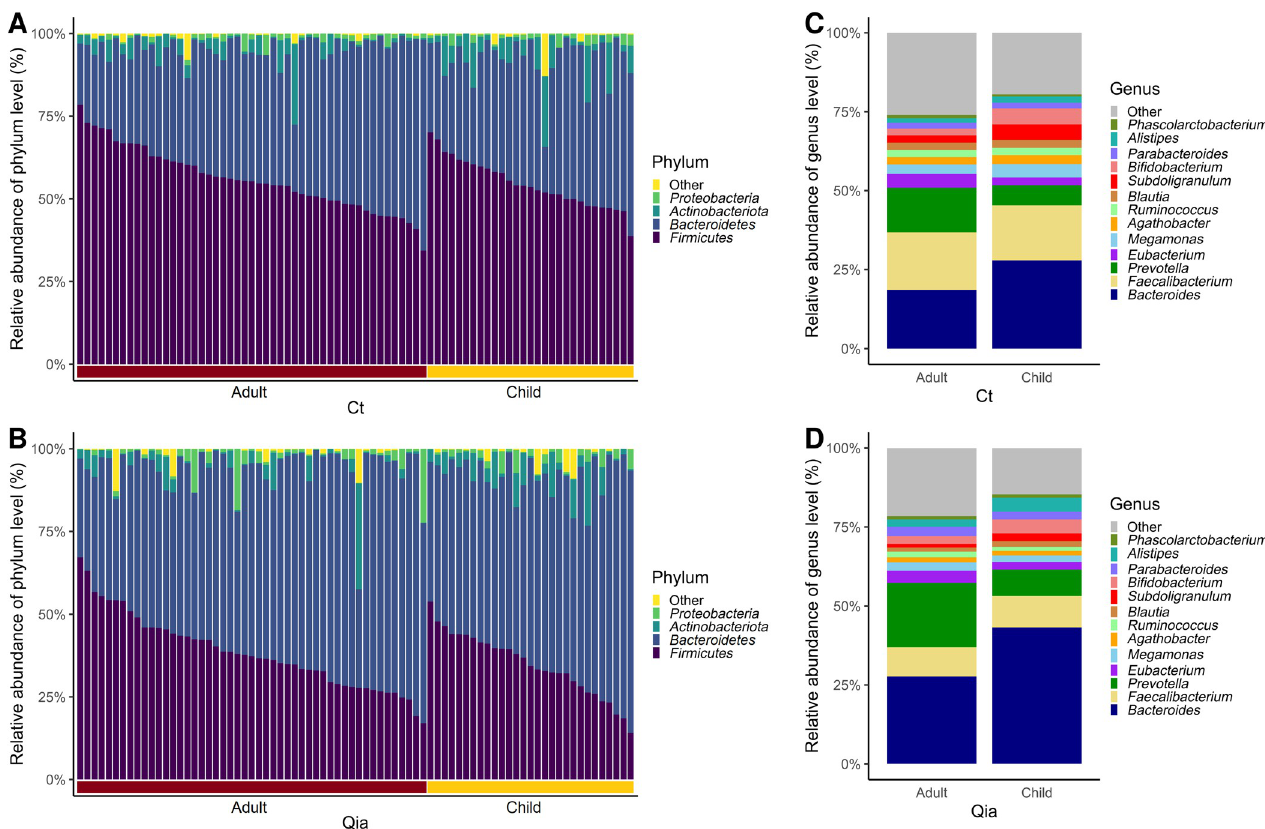
Fig 2. Relative abundance of microbiome of adults and children. A. Variation in bacterial relative abundance at the phylum level with Ct kit. B. Bacterial relative abundance at the phylum level with Qia kit. C. Bacterial relative abundance at the genus level with Ct kit. D. Bacterial relative abundance at the genus level with Qia